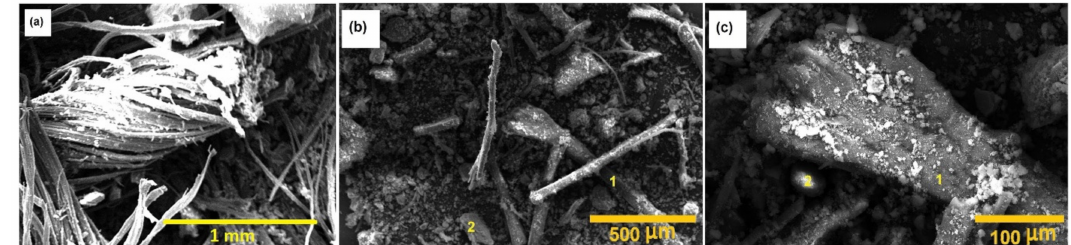
Figure 14. SEM micrographs of ( a ) jute fibers, ( b ) jute-fiber-reinforced geopolymers composites (lower magnification) where 1 shows jute fibril and 2 shows geopolymer aggregates and ( c ) jute fibers reinforced geopolymers composites (higher magnification) where 1 shows jute fibril and 2 shows geopolymer aggregates. Reprinted with permission from Ref. [147]. Copyright 2021, with permission from